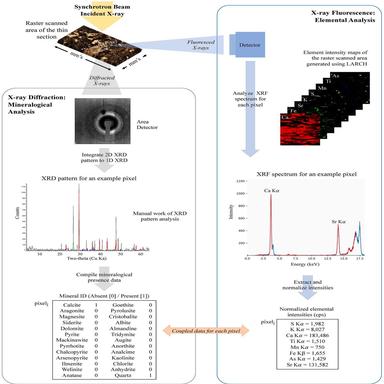
The methodology for acquisition of data for training of the classifier in the SMART mineral mapping approach.